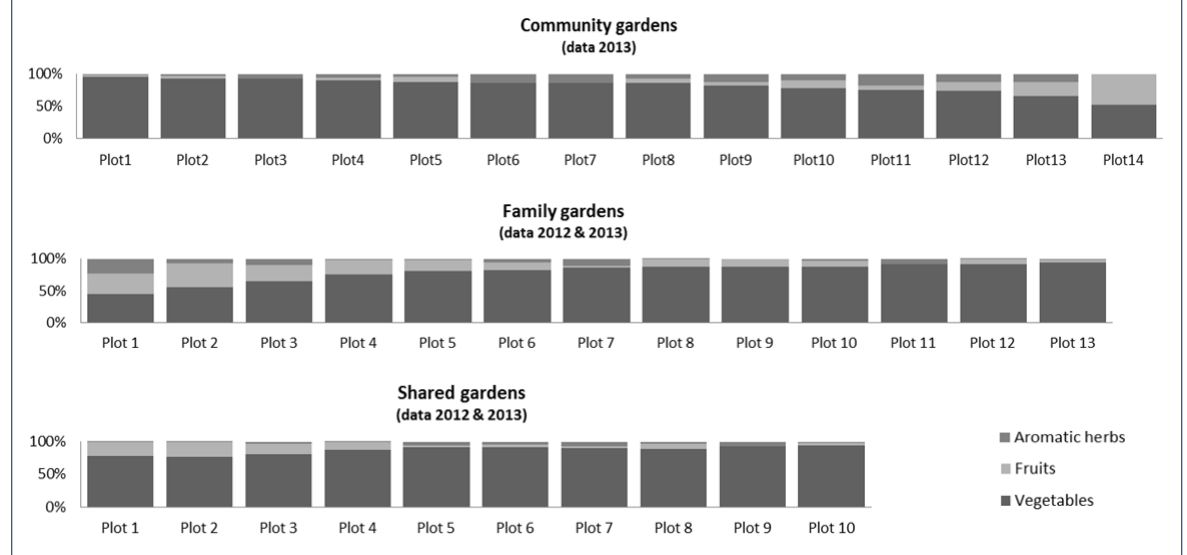
Figure 9. Importance of Each Type of Crop (Vegetables, Fruits, and Aromatic Herbs) in Collective Garden Plots (% of total S d